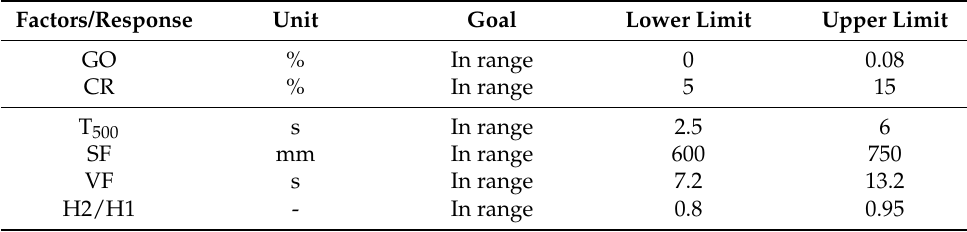
Table 4. Optimization criteria and